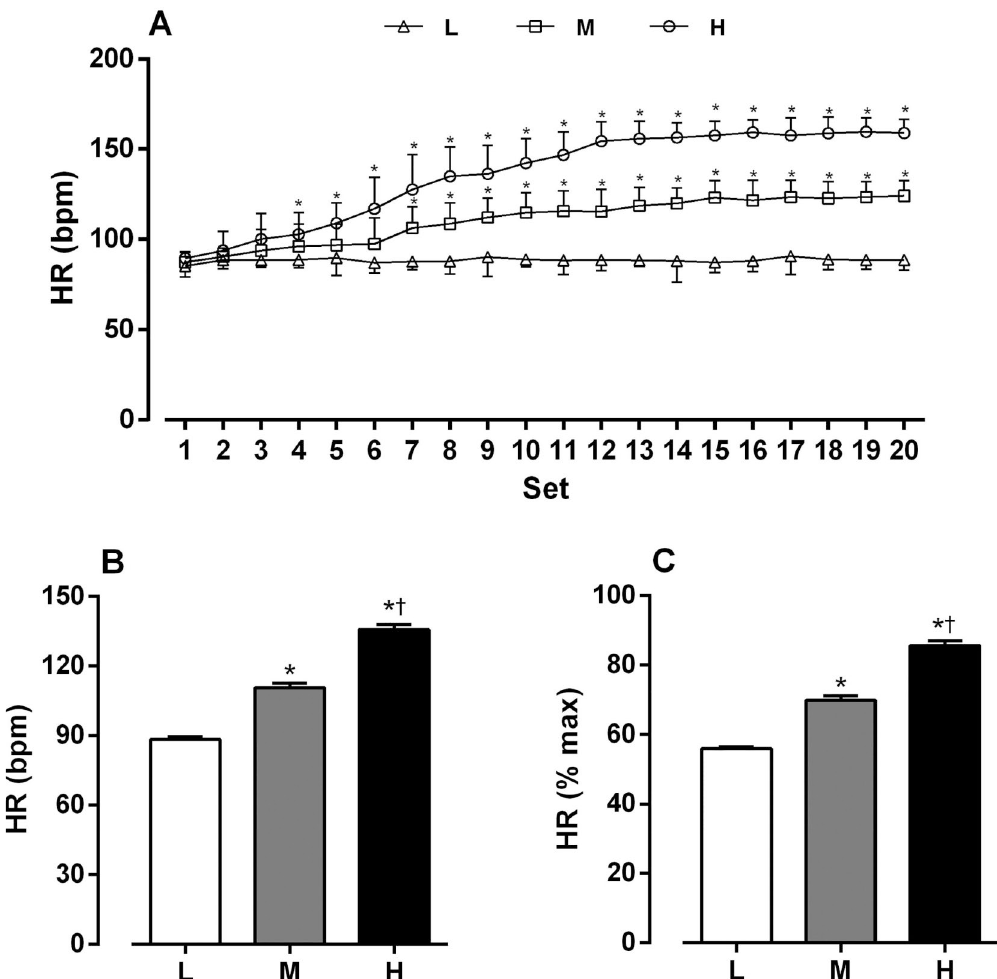
Figure 2 - Values expressed as mean ± standard deviation of feeling scale before and after carrying out the protocols of low (L), moderate (M), and high (H) cadences of the rate of heart rate (HR) in all sets (Panel A), mean of the session (Panel B) and relative (Panel C). *p < 0.01 vs. first set top Panel A. *p < 0.01 vs. L, † p < 0.01 vs. M to Panel B